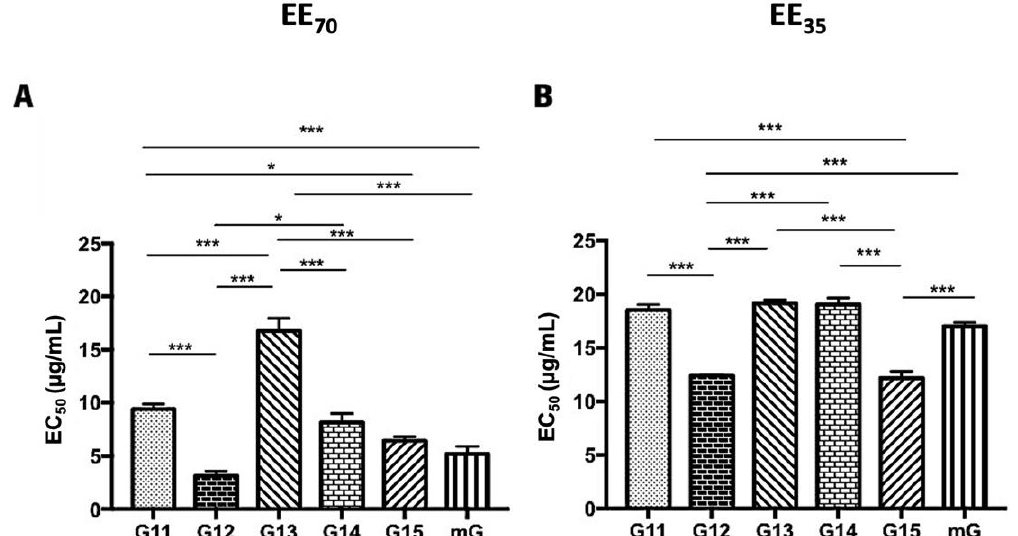
Figure 3 . DPPH scavenging capacity of propolis hydroalcoholic extracts from Gerês. Propolis hy- Figure 3. DPPH scavenging capacity of propolis hydroalcoholic extracts from Ger ê s. Propolis droalcoholic extracts have ethanol 70% ( v / v ) (EE 70 ) or 35% (EE 35 ). Results are expressed in EC 50 hydroalcoholic extracts have ethanol 70% ( v / v ) (EE 70 )—( A ) or 35% (EE 35 )—( B ). Results are expressed (µg/mL) as mean ± SEM. (* 0.05 > p ≥ 0.01, ** 0.01 > p ≥ 0.001, *** p < 0.001) (DPPH: 2,2-diphenyl-2- in EC 50 ( µ g/mL) as mean ± SEM. (* 0.05 > p ≥ 0.01, *** p < 0.001) (DPPH: 2,2-diphenyl-2-picry- lhydrazyl; G: Ger ê s; mG: a mixture of propolis